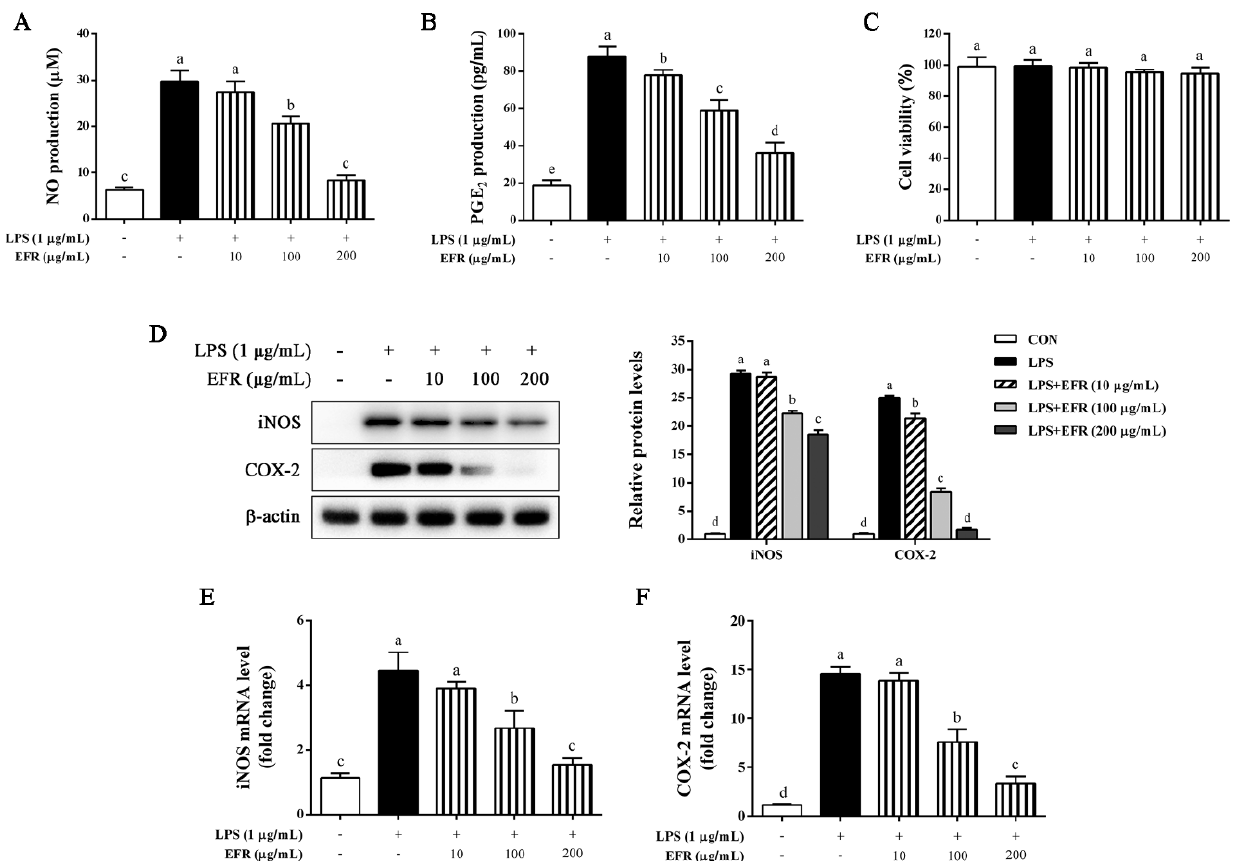
Figure 1. Effect of EFR on LPS-induced NO and PGE 2 production and iNOS and COX-2 expression in RAW 264.7 macrophages. RAW 264.7 macrophages were pretreated with EFR (10, 100, and 200 μg/mL) for 2 h and then stimulated with or without LPS (1 μg/mL) for 24 h. ( A ) The nitrite concentration in the cultured media was determined as an indicator of NO production by Griess reaction. ( B ) PGE 2 production in the cultured media was determined by ELISA. ( C ) The cell viability was determined by MTT assay. ( D ) The protein levels of iNOS and COX-2 were determined by Western blot analysis. β -actin was used as an endogenous control. Relative intensity of the immunoreactive bands was analyzed using the Image J software. The mRNA levels of iNOS ( E ) and COX-2 ( F ) were determined by qPCR. Results are shown as the mean ± SD of three independent experiments. The different letters represent the statistical differences at p < 0.05 among the groups by Duncan’s multiple range test.